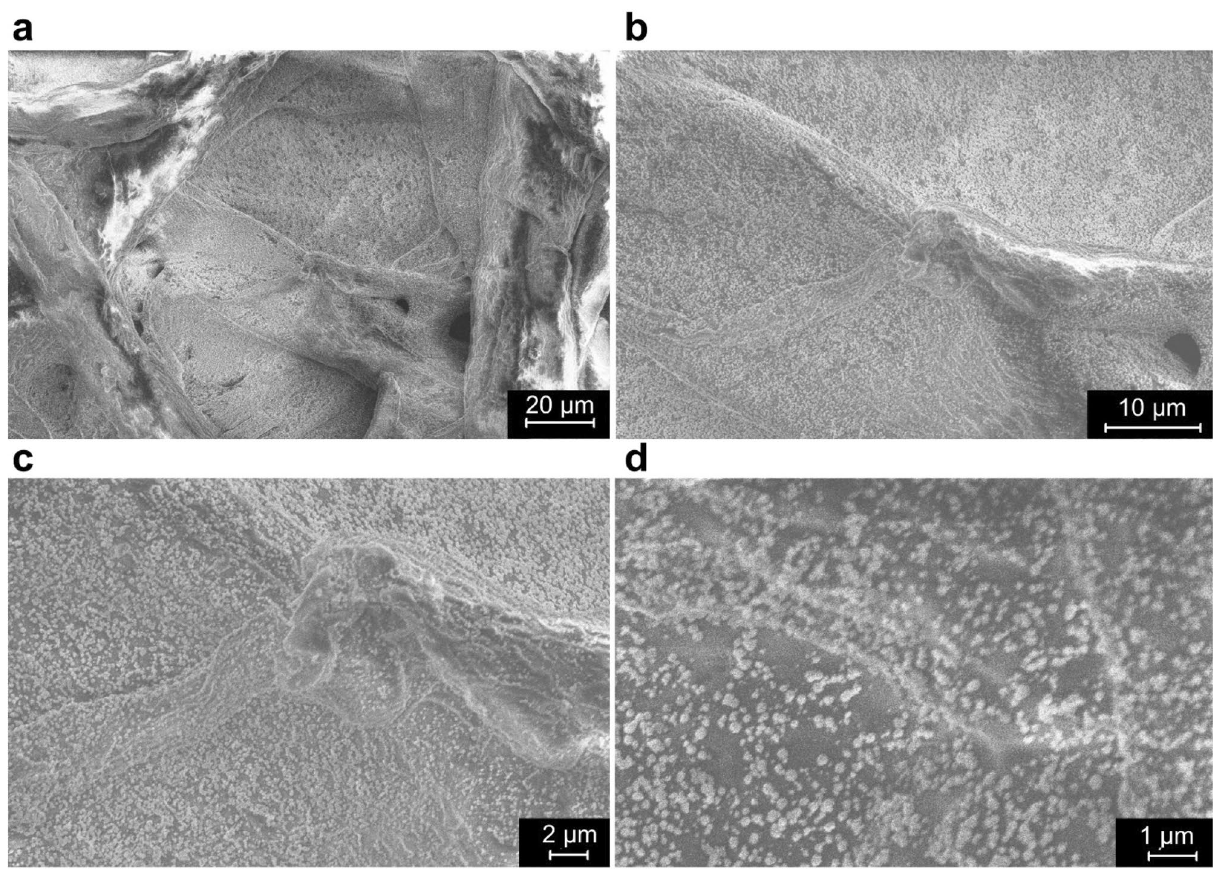
Figure 4. FE-SEM images of the accumulation of particles inside an inter-fiber’s cavity in the medium‑dark region. Different magnifications are proposed: ( a ) 1.8 K×, ( b ) 5 K×, ( c ) 10 K×, ( d ) 25 K×. The size of particles varies between 200 and 300 nm. This type of structure was also found in the dark regions, while no detection was possible in the white